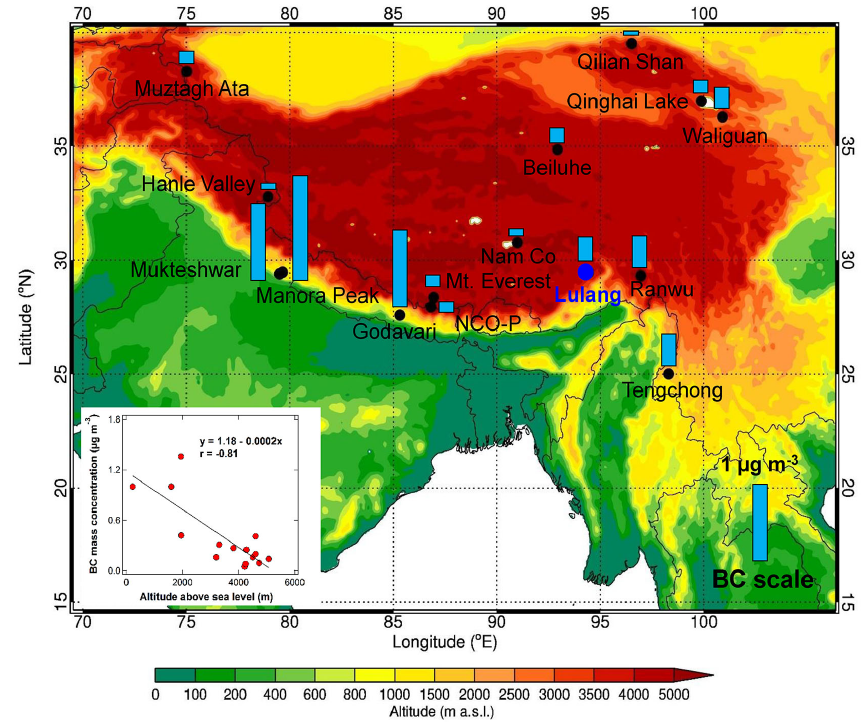
Figure 1. Black carbon concentrations (µgm − 3 ) measured at 15 sampling sites in the Himalayas and on the Tibetan Plateau based on the measurements from this study (blue solid circles) and other studies (black solid circles) from Ma et al. (2003), Pant et al. (2006), Marinoni et al. (2010), Stone et al. (2010), Babu et al. (2011), Engling et al. (2011), Zhao et al. (2012), Li et al. (2017), Wan et al. (2015), Wang et al. (2015a), M. Wang et al. (2016), Zhu et al. (2016), and Raatikainen et al. (2017). More detailed information concerning these studies is summarized in Table S1. The inset is a scatter plot of the mass concentrations of BC versus the altitude of each sampling site. The map in the figure was drawn using the Weather Research and Forecasting (WRF)